Question: Give a one-sentence summary of this figure.
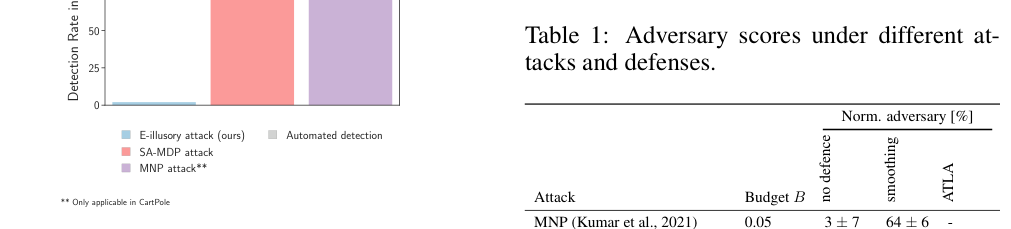
Answer: Detection results for B = 0.05. Dif- ferent adversarial attacks are shown on the x- axis, with detection rates on the y-axis. We see that the automated reliably detector detects SA- MDP and MNP attacks, while ϵ-illusory attacks are less likely to be detected.